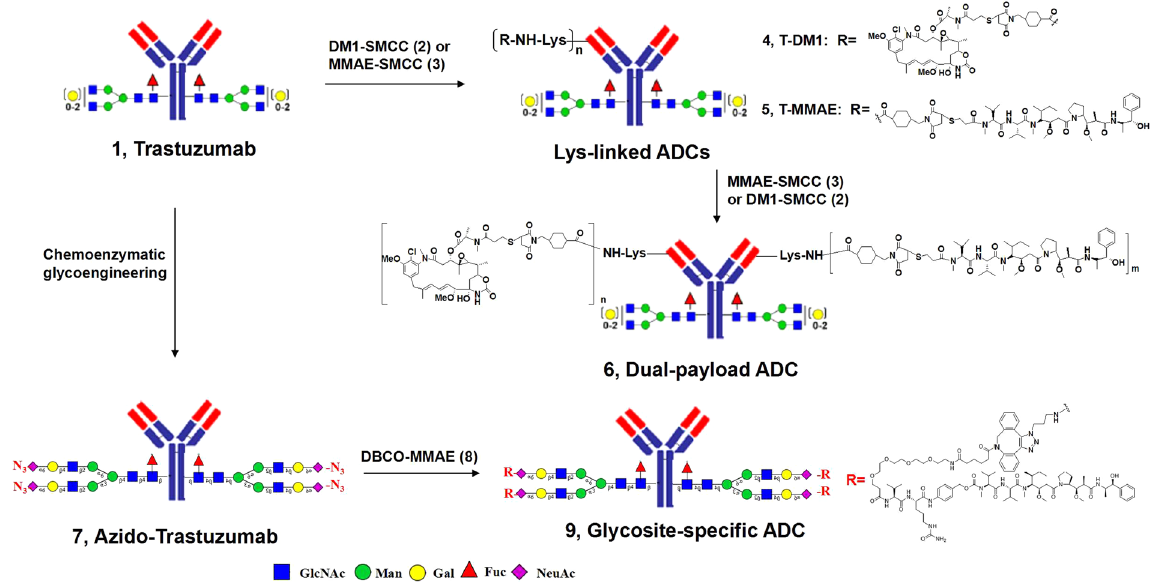
Figure 1. The synthesis of lysine-linked ADCs, dual-payload ADC, and glycosite-specific